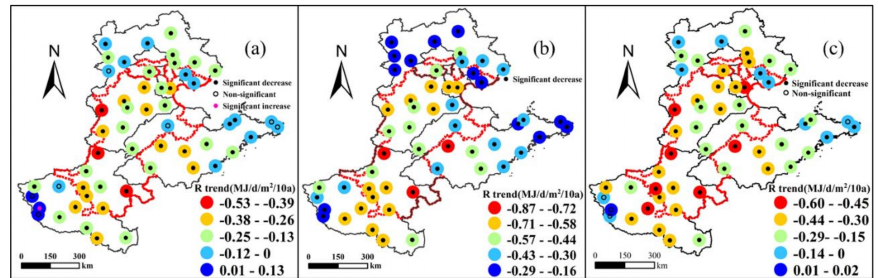
Figure 5. The spatial distribution and statistical significance of the trends in the daily solar radiation (R)